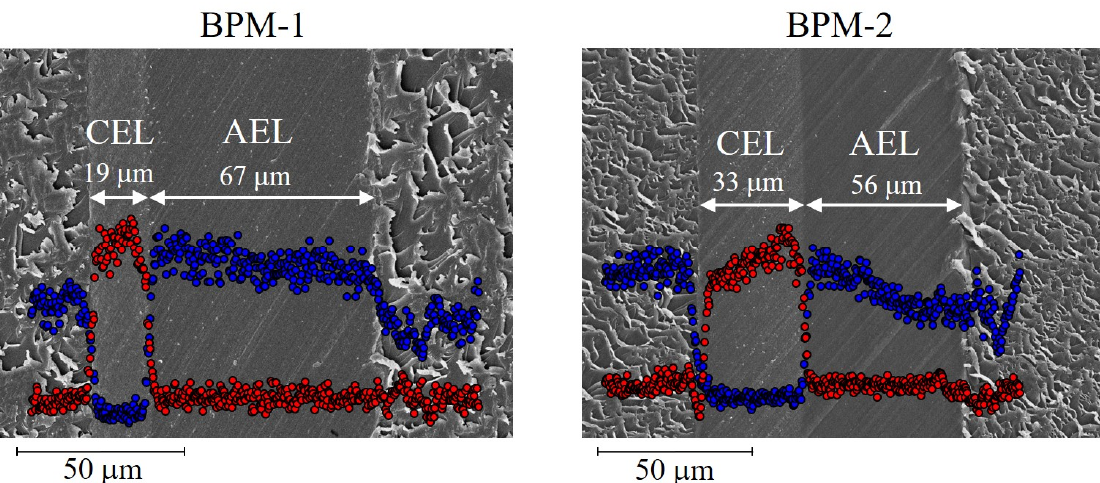
Figure 6. SEM images and concentration profile of sulfur (red circle) and chlorine (blue circle) of the cross-section of the prepared BPMs.